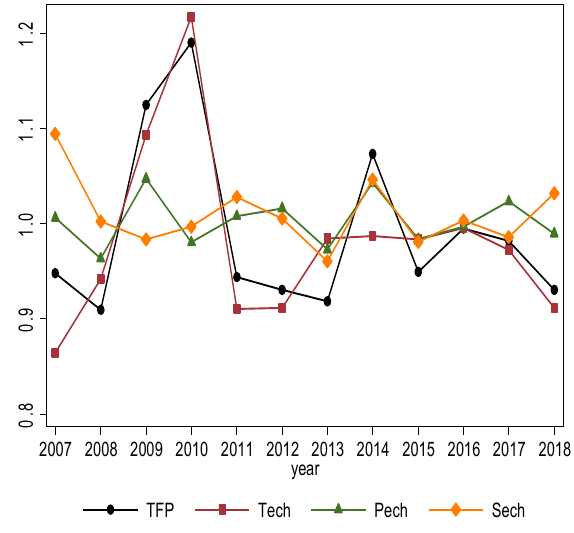
Figure 3. Trends in Production Efficiency of Japonica Rice from 2007 to 2018.